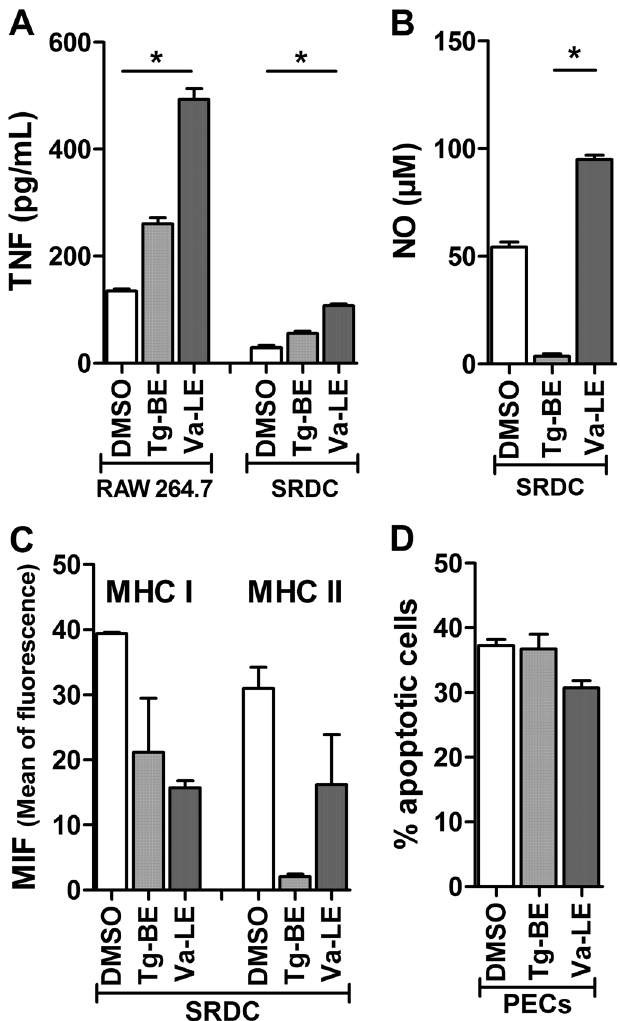
Figure 2. Cytokine production, MHC expression, and apopto- sis of antigen-presenting cells. RAW 264.7 macrophages (A), SRDC dendritic cells (A, B, C), or peritoneal exudate cells (PECs) (D) were stimulated for 24h with 10 m g/mL of Tg-BE or Va-LE, or with DMSO as negative control. TNF- a (A) and NO (B) were quanti fi ed in supernatant by sandwich ELISA and the Griess method, respectively (n =3). Expression of MHC molecules of classes I and II was measured by fl ow cytometry after labelling with speci fi c antibodies (n= 2). Apoptosis was evaluated by fl ow cytometry after labelling with annexin V- FITC and propidium iodide (n=3). Results are mean ± S.D. * p < 0.05 (Dunn ’ s multiple comparison